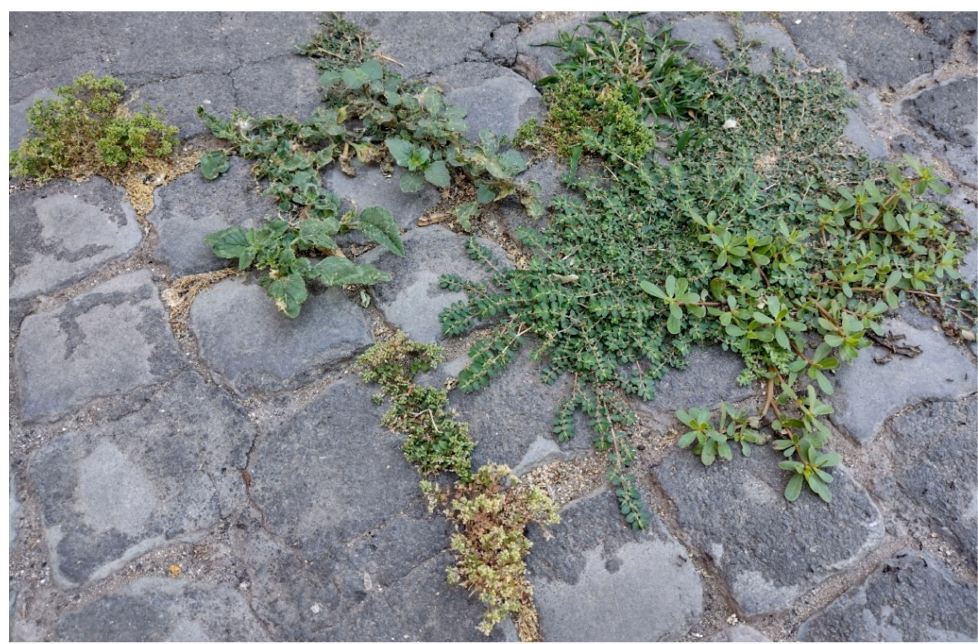
Figure 30. Trisetaria panicea dominated community, Sisymbrietea (Caffarella locality). 13. Polygono-Poetea annuae Rivas-Mart. 1975: nitrophilous pioneer vegeta- tion of trampled habitats. This type of vegetation is common, especially on roadsides and crevices of paved roads (Figure 31).